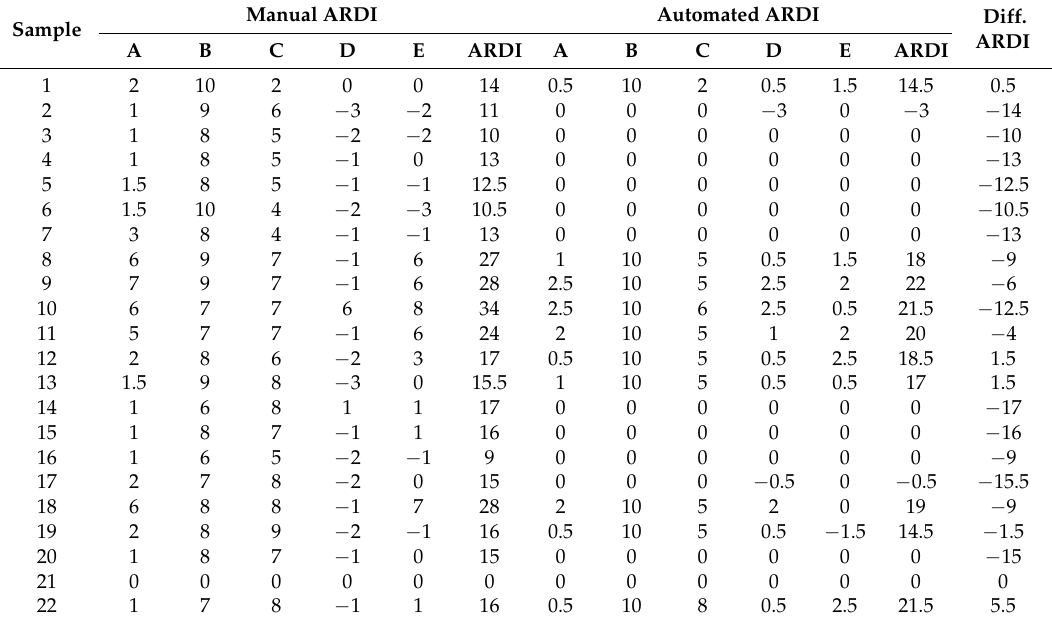
Table 1. Automated and manually derived acid rock drainage (ARD) indicator and index values.